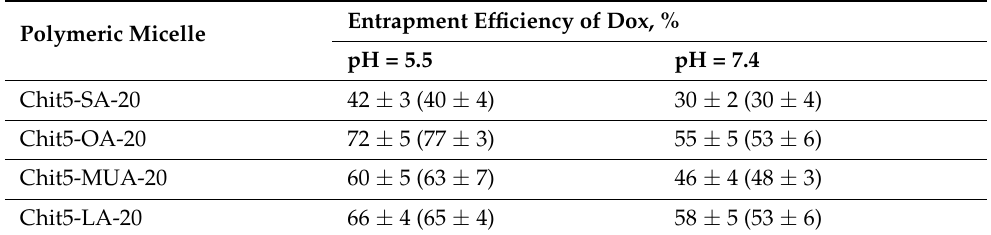
Table 2. Entrapment efficiency of Dox in polymeric micelles determined using FTIR spectra deconvo- lution with Lorentzian (Figure 5) and analytical dialysis (the data are given in parentheses). pH =